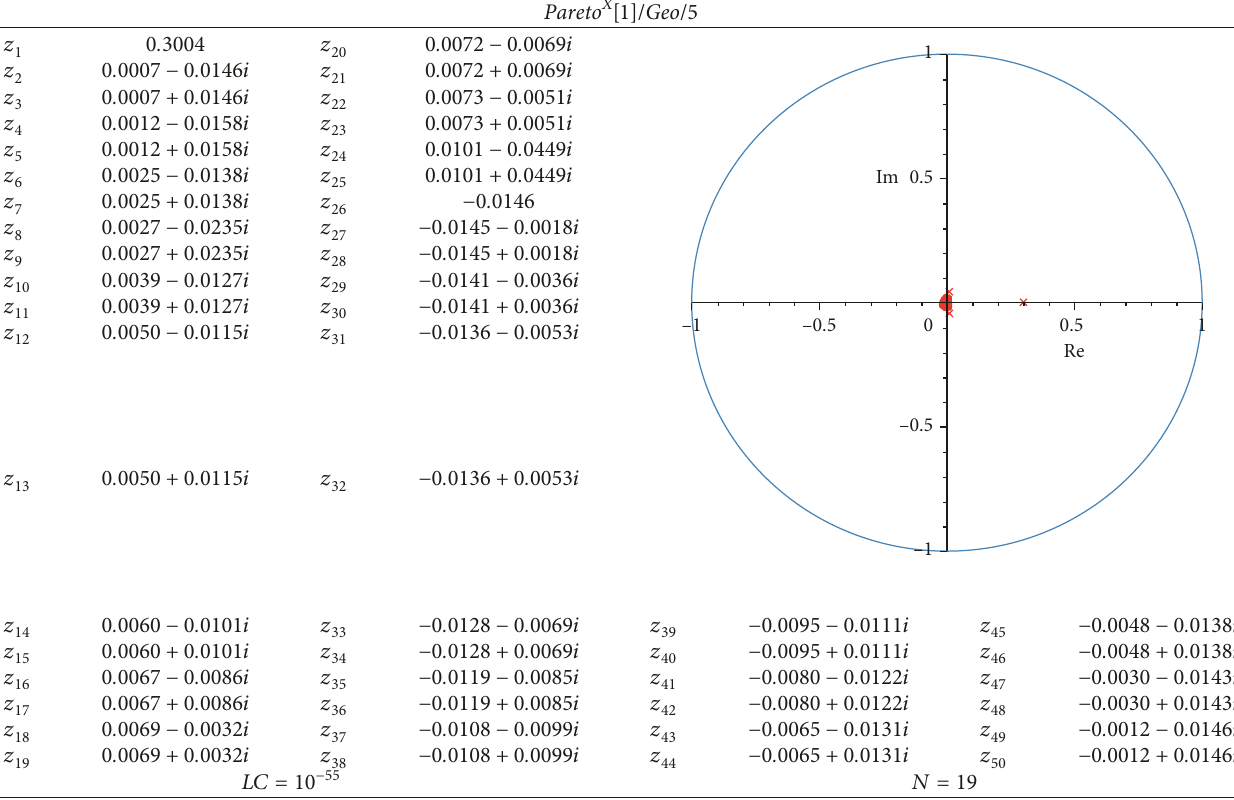
Table 4: Normalized Poisson batch size distribution with b